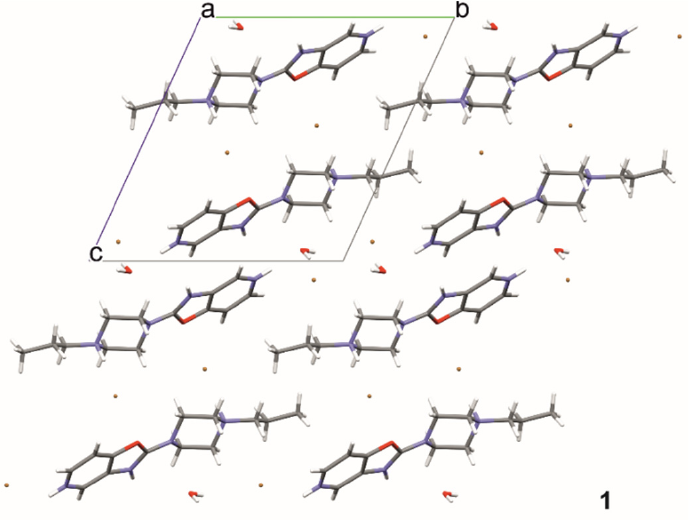
Figure 6. The intermolecular hydrogen bonds in compound 1 . ( a ) Strong hydrogen bonds, ( b ) all hydrogen bonds. [Symmetry code: (i) x − 1, y, z; (ii) − x, − y, − z+2; (iii) − x, − y+1, − z+1; (iv) − x+1, − y+1, − z+2.] .